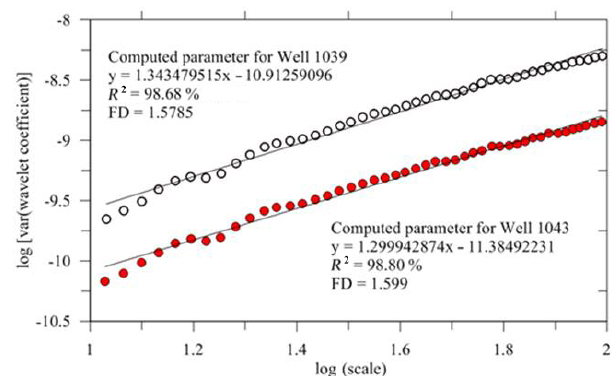
Figure 10. Variance of wavelet coefficients versus scale of density log of well sites 1039 and 1043, which show consistent holder expo- nent and fractal-dimension values, indicating that the wells contain a similar sedimentary environment.